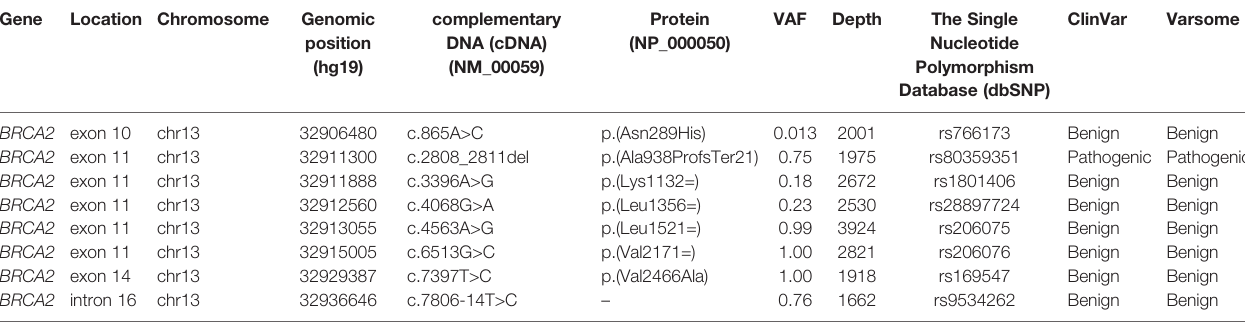
TABLE 1 | BRCA2 somatic variants of the patient 1.